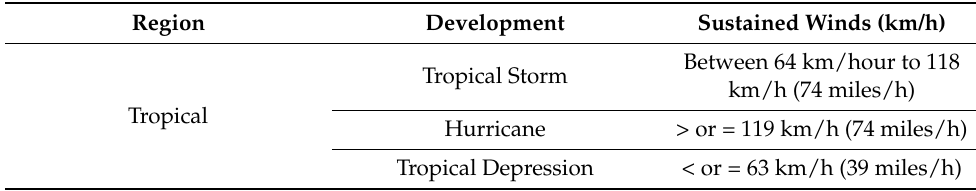
Table 1. Hurricane classification with respect to wind range.